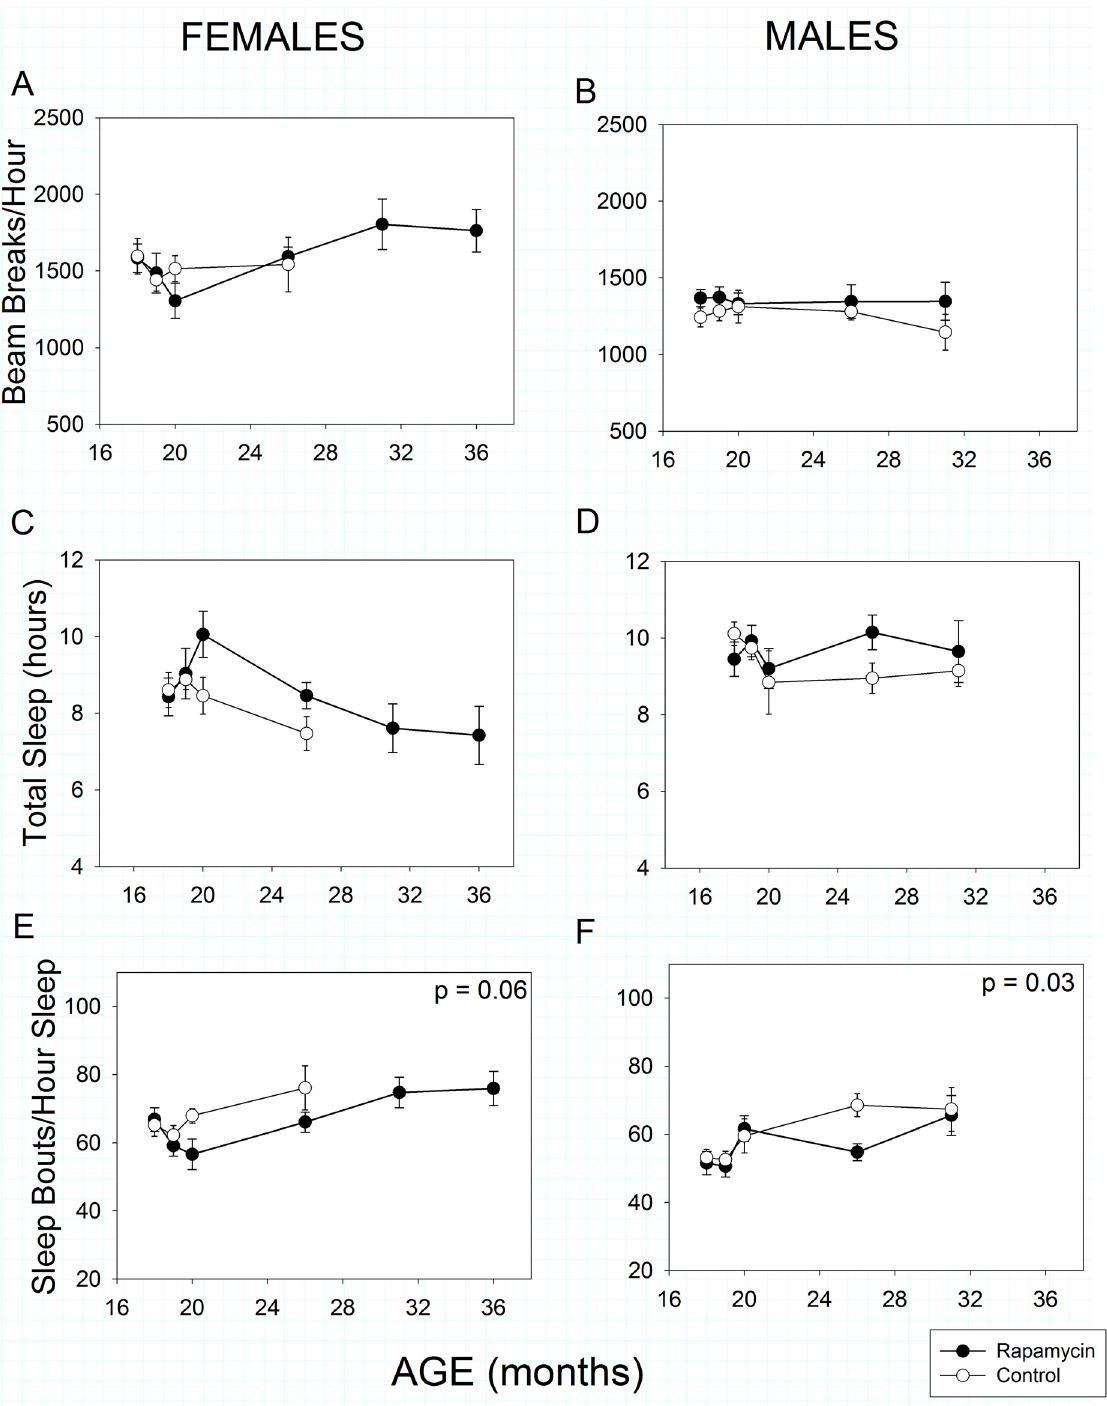
Fig 4. Spontaneous activity and sleep in rapamycin-fed mice (filled circles) compared to controls (hollow circles). P-values shown on individual panels only if there is a significant treatment effect independent of age. Sample sizes varied, depending on age, control females, n = 14 – 2; rapamycin females, n = 18 – 5; control males, n = 13 – 4; rapamycin males, n = 22 – 7. A, B: Spontaneous 24-hour activity was greater in females than males (p << 0.001). Activity increased with age (p = 0.008) in females and decreased with age in males (p = 0.003), regardless of treatment. C, D: Total sleep Rapamycin treatment marginally increased total sleep in both sexes (p = 0.05) when taken together, but aging affected sleep patterns in the two sexes differently (age x sex, p << 0.001). E, F: Sleep fragmentation increased with age in all animals (p << 0.001); however, rapamycin treatment reduced sleep fragmentation in males and showed a trend to reduce it in